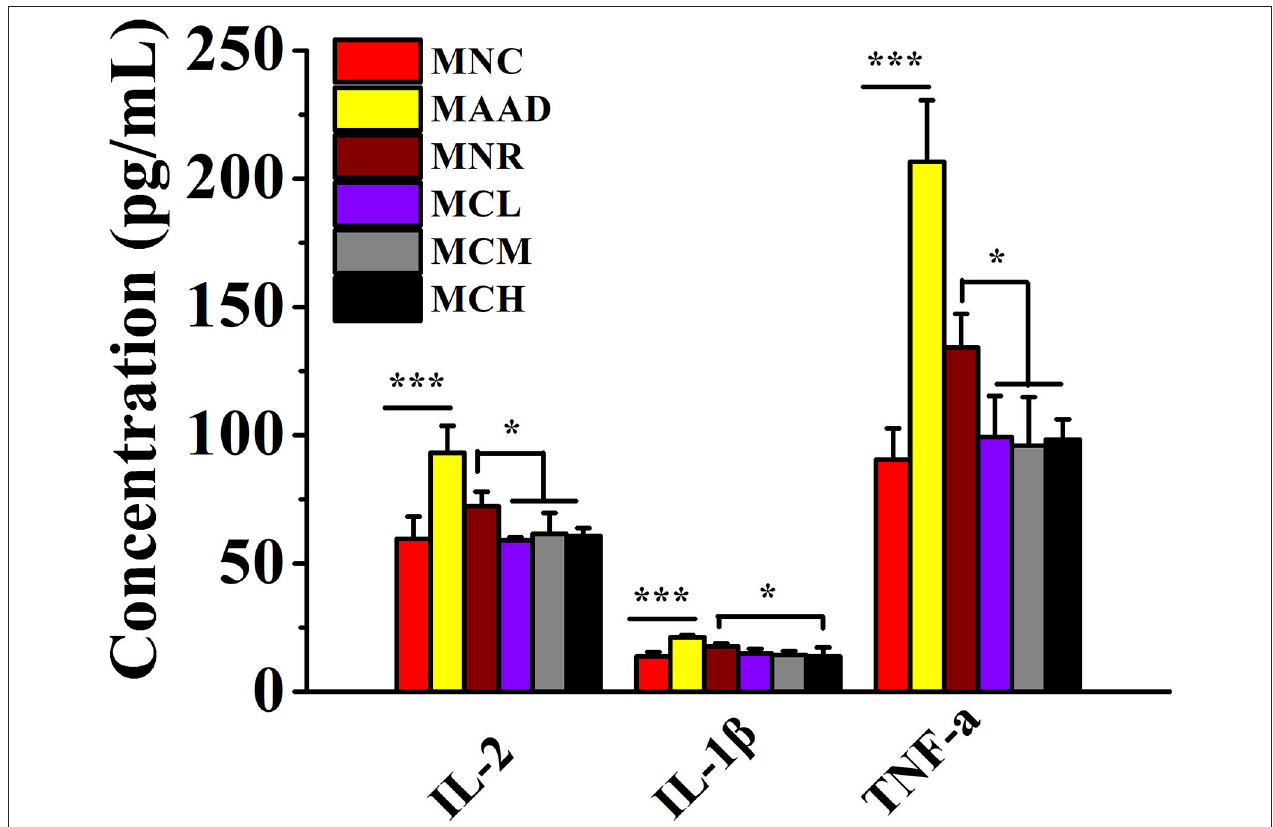
FIGURE 3 | Changes in the secretion of inflammatory factors. Values are shown as means ± SD. * p < 0.05, *** p <